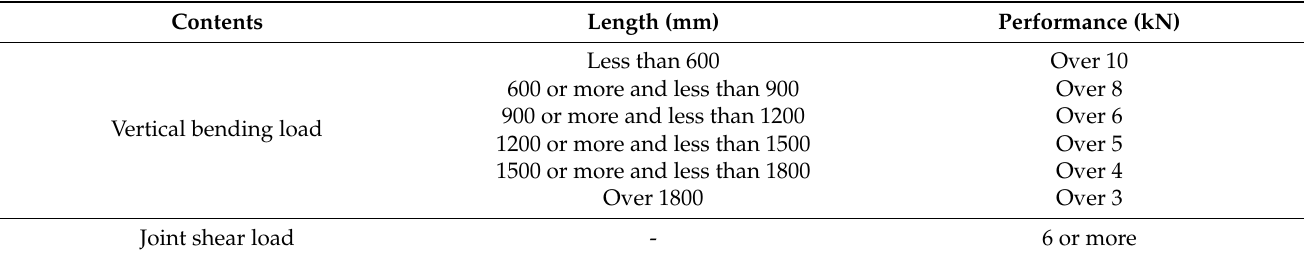
Table 2. Test performance standard for the horizontal members of the prefabricated shoring system in Korea [36].